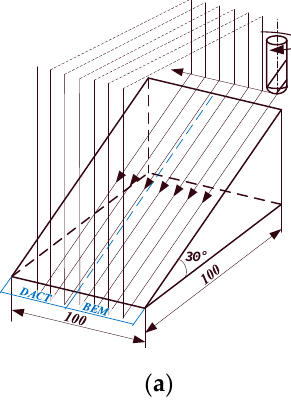
Figure 15. Milling mode of the workpieces: ( a ) inclined plane; ( b ) concave – convex ruled surface.